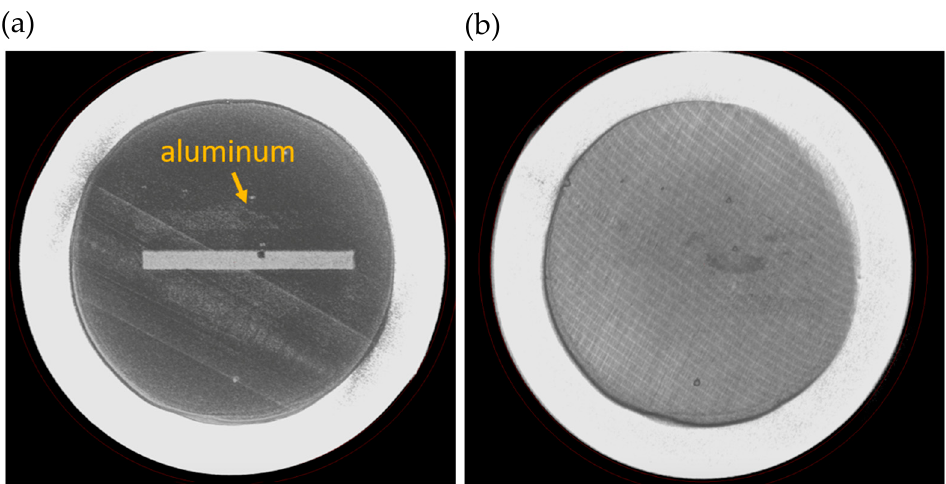
Figure 10. XCT images of AM aluminum melt wire. ( a ) Original XCT image of aluminum encapsulated in helium, ( b ) post-furnace image of melt wire capsule with the aluminum wire not discernable against the SS316 substrate.